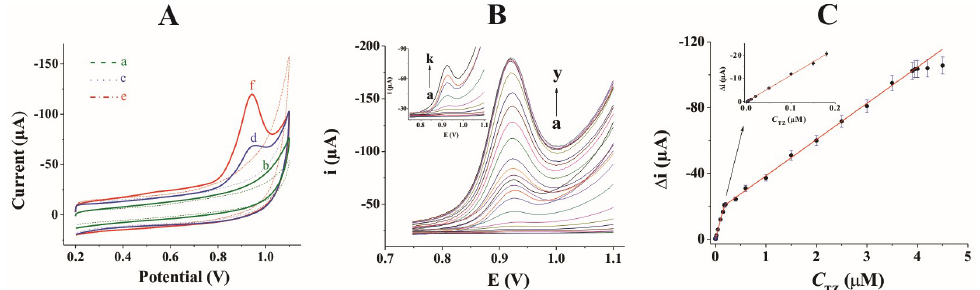
Figure 4. ( A ) CVs of (a) GCE/GO@NIPDA, (b) GCE/GO@MIPDA, (c) GCE/GO–Pt@NIPDA, (d)